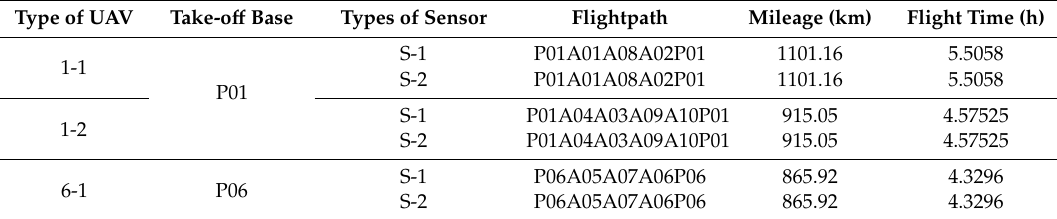
Table 5. Solution results of hierarchical decision-making